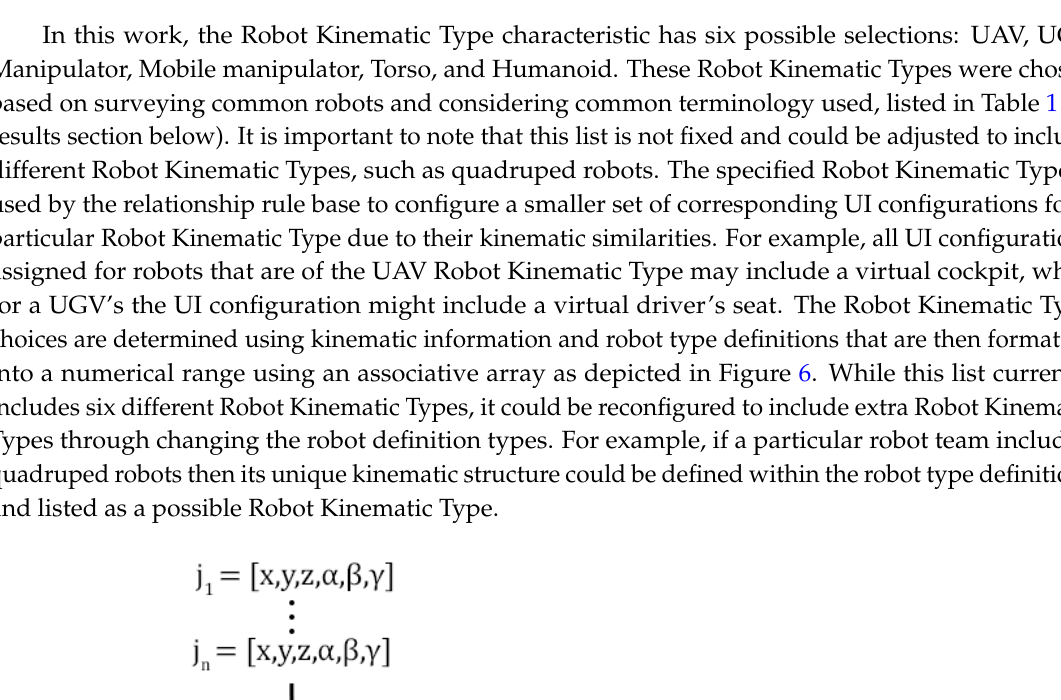
Figure 7. Grouping Sensor Types into sensor presentation groups using rules determined in this work. The relationship rules are used to implement logic based on the specified robot characteristics. The No. of Sensors characteristic specifies the maximum number of sensors onboard any given robot included in the selected Robot Kinematic Type. Considering the No. of Sensors characteristic, they can be clustered where a large amount is present on an individual robot. Clustering the sensors into